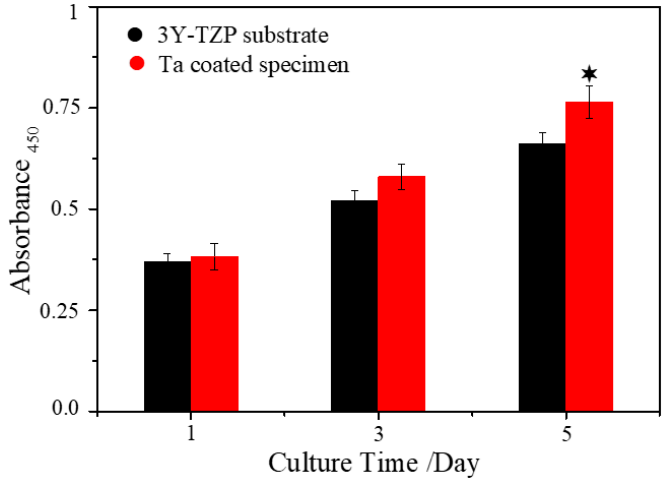
Figure 9. Proliferation results of osteoblasts on the uncoated and Ta coated specimens for 1, 3 and 5 days: ＊ p < 0.05 compared to control. 5 days: (cid:86) p < 0.05 compared to